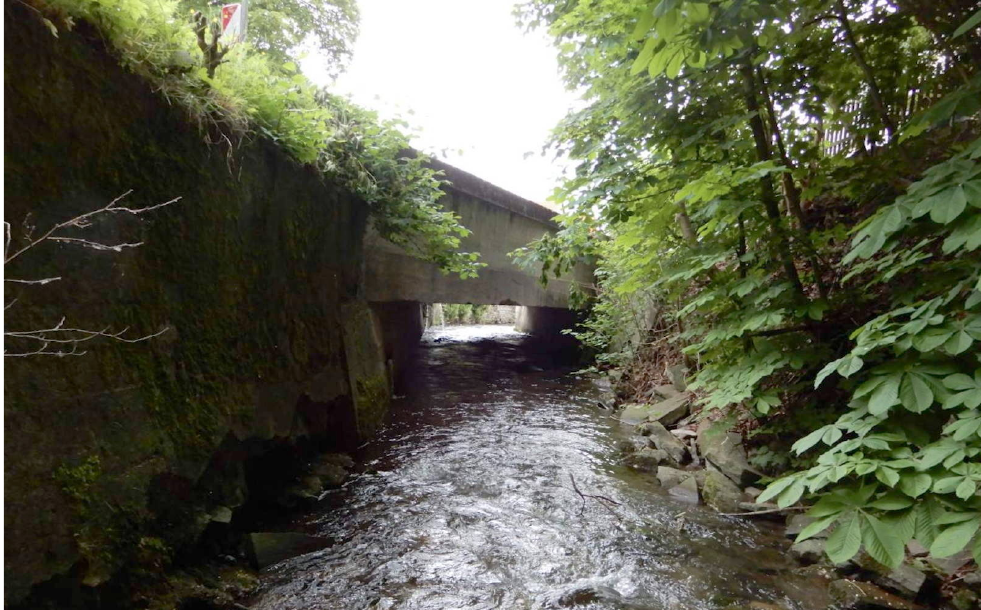
Figure 9. Bridge that has been used for the investigation. Name and location of the bridge are